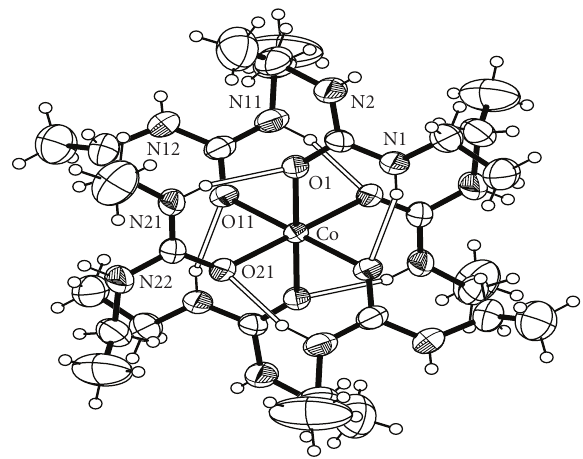
Figure 1: An ORTEP representation of the cation [Co(DEU) 6 ] 2+ present in complex 1 . Open bonds indicate intramolecular hydro- gen bonds. The symmetry-equivalent atoms are not